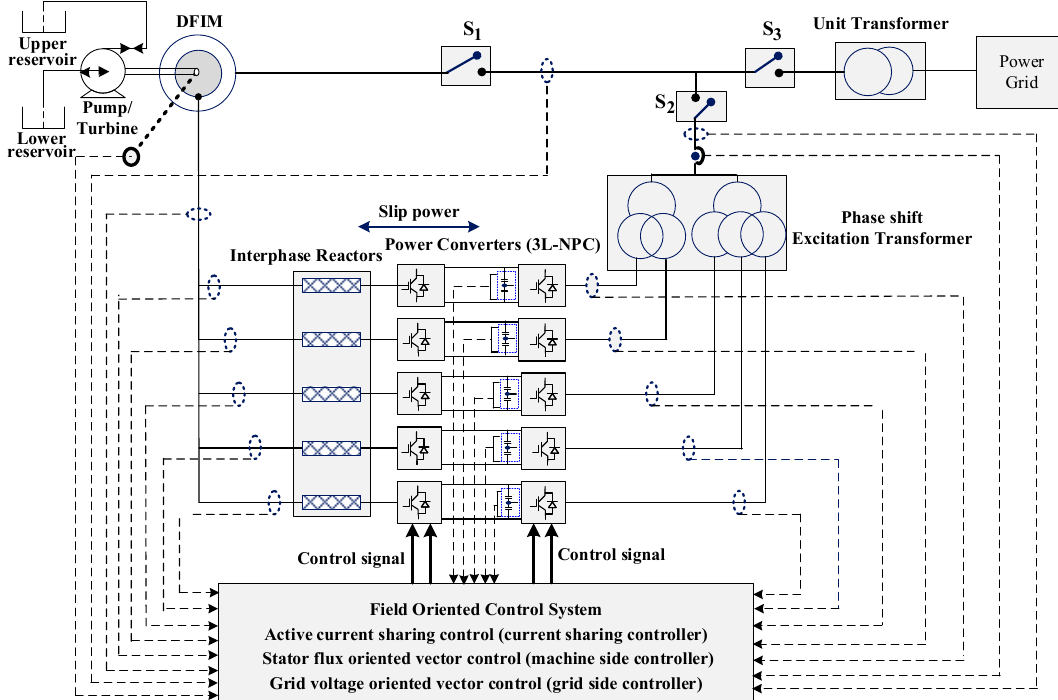
Figure 1. Large-rated DFIM-based variable speed PSPP unit.